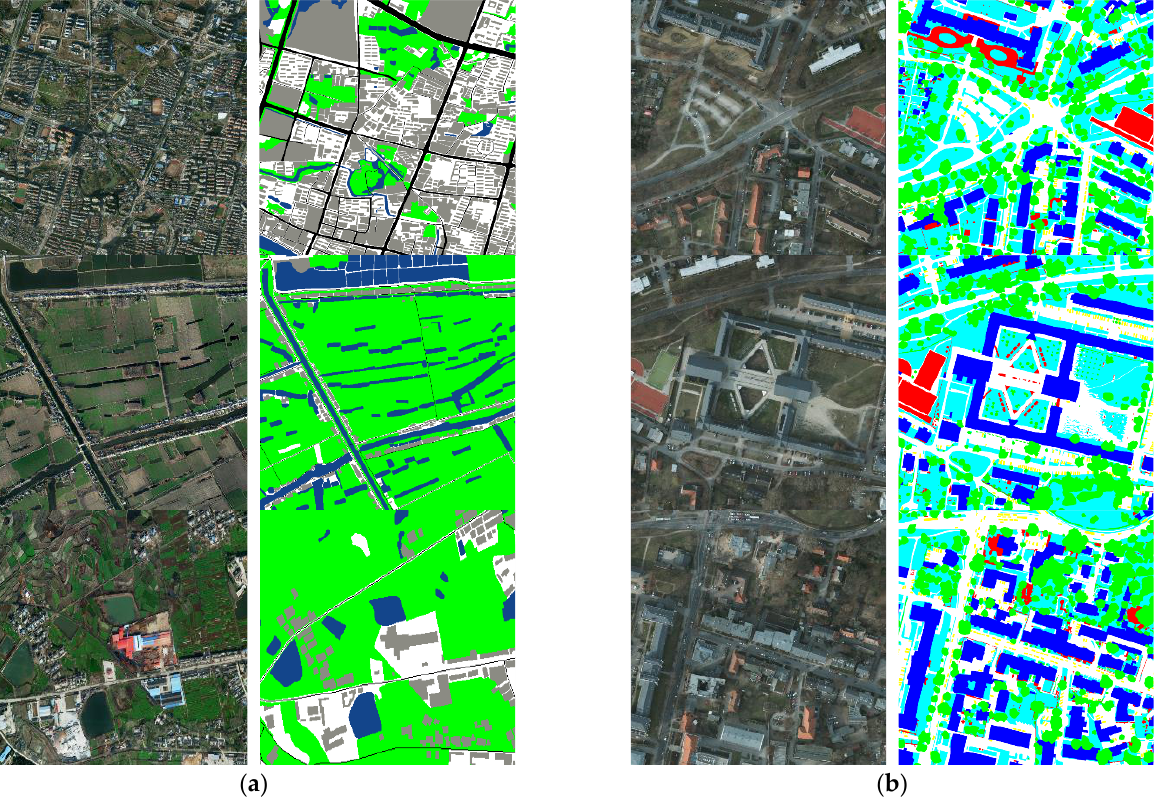
Figure 10. Examples of original and annotated images of two different styles of remote sensing datasets used for the experiments in this paper: ( a ) the BDCI 2017 dataset and ( b ) the ISPRS Potsdam dataset, respectively.